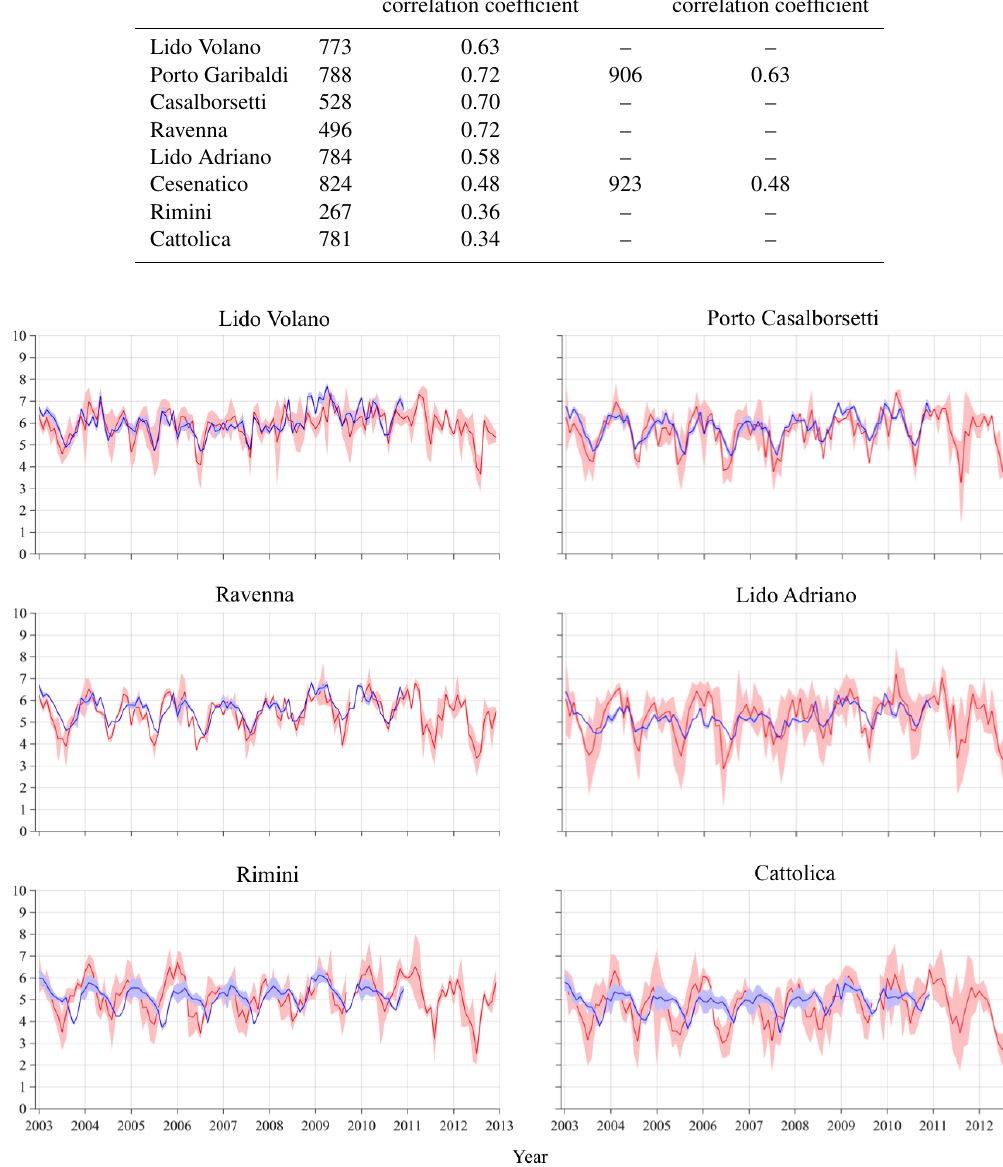
Figure 5. Comparison between in situ TRIX (red line) and model TRIX (blue line) averaged over six transects (Lido Volano, Casalborsetti, Ravenna, Lido Adriano, Rimini, and Cattolica) comprising the ARPAE-Daphne monitoring sampling program. Red and blue shaded areas correspond to average values ± 2 standard